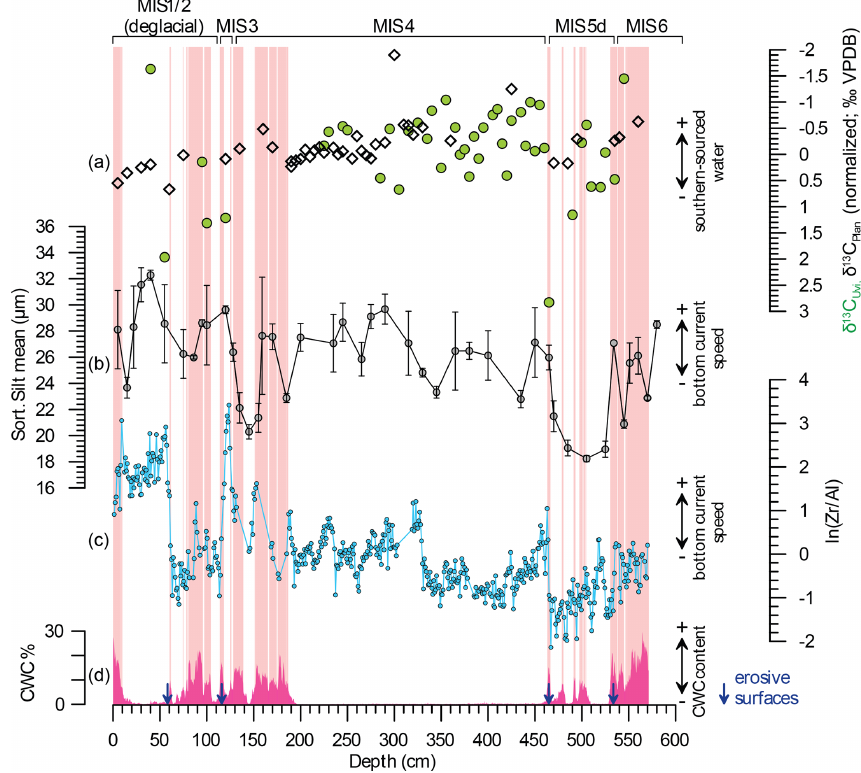
Figure 4. Proxies of intermediate water-mass variability vs. phases of mound formation obtained in core M125-34-2. (a) Normalized δ 13 C of Uvigerina spp. (green dots) and P. wuellerstorfi (white diamonds) as a proxy for bottom-water-mass origin; (b) mean sortable silt (SS) reflecting bottom-current speed; (c) XRF-derived sedimentary ln(Zr / Al) ratio, which is dependent on bottom-current speed (Bahr et al., 2014) and advection of fine-grained material from the nepheloid layer; and (d) CWC abundances based on CT scanning. Phases of CWC proliferation appear to require background state of high hydrodynamic conditions (elevated ln(Zr / Al) and SS) but do not show an influence of deep-water-mass variability ( δ 13 C). Light red shadings denote intervals, with coral contents > 7% used for discriminant analysis; blue arrows indicate erosive